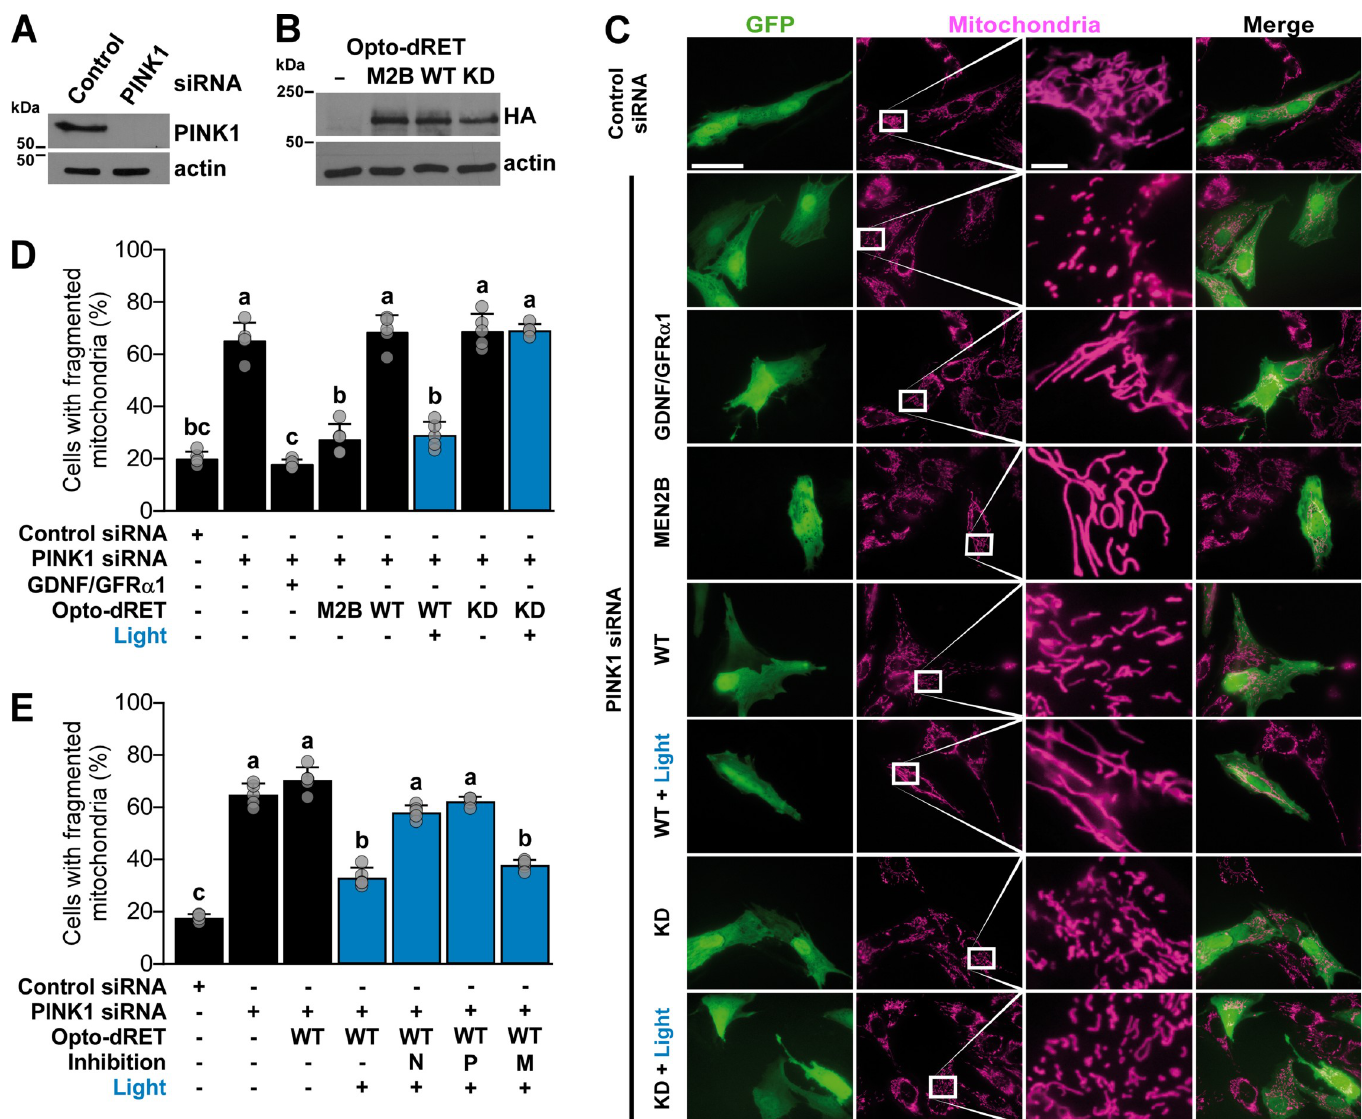
Fig 5. Rescue of mitochondrial fragmentation in human cells. ( A and B ) WB analysis of PINK1 knock-down by siRNA and Opto-dRET expression. ( C ) Representative images for fragmentation of mitochondria induced by PINK1 silencing. Magenta: MitoTracker. Green: GFP marker. Scale bar: 200 (columns 1, 2) or 20 μ m (columns 3, 4). ( D ) Quantification of mitochondrial fragmentation upon light stimulation of RET, Opto-dRET, Opto-dRET MEN2B or Opto-dRET KD (I = 232 μ W/cm 2 , λ = 470 nm, 4 h continuous). ( E ) Quantification analysis of mitochondrial fragmentation upon light activation of Opto-dRET and inhibition of NF- к B signaling (by I κ B-2S/A, label “N”), PI3K (by LY294002, label “P”) or MEK1 (by PD98059, label “M”). For D and E, mean ± SD for five independent experiments is given (at least 150 cells per condition in each experiment). Means sharing the same label are not significantly different (ANOVA/Bonferroni corrected t-tests, p >